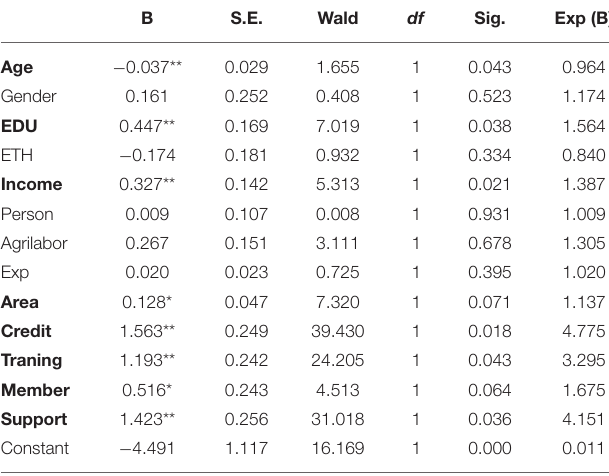
TABLE 9 | Results of binary logit